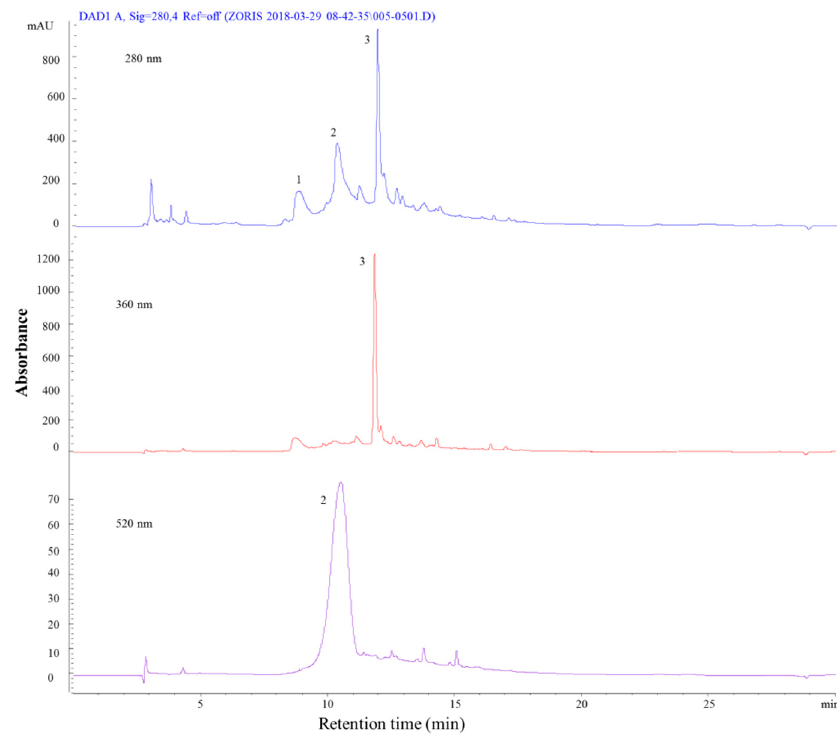
Figure 5. HPLC-PDA chromatograms of eggplant recorded at 280, 360 and 520 nm. Table 5. Characterization of phenolic compounds in eggplant via positive